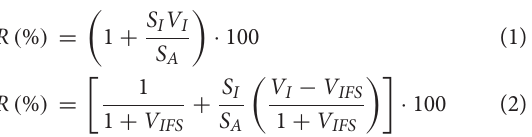
V I is percent difference between interfering ion signal values recorded for the sample and its corresponding standard solution (i.e., it represents how much the interfering ion signal has varied from the time the calibration standards were run to when the sample was analyzed), S A is the analytical signal, and V IFS is the percent difference between IFS signal values recorded for the sample and its corresponding standard solution (i.e., similar to V I